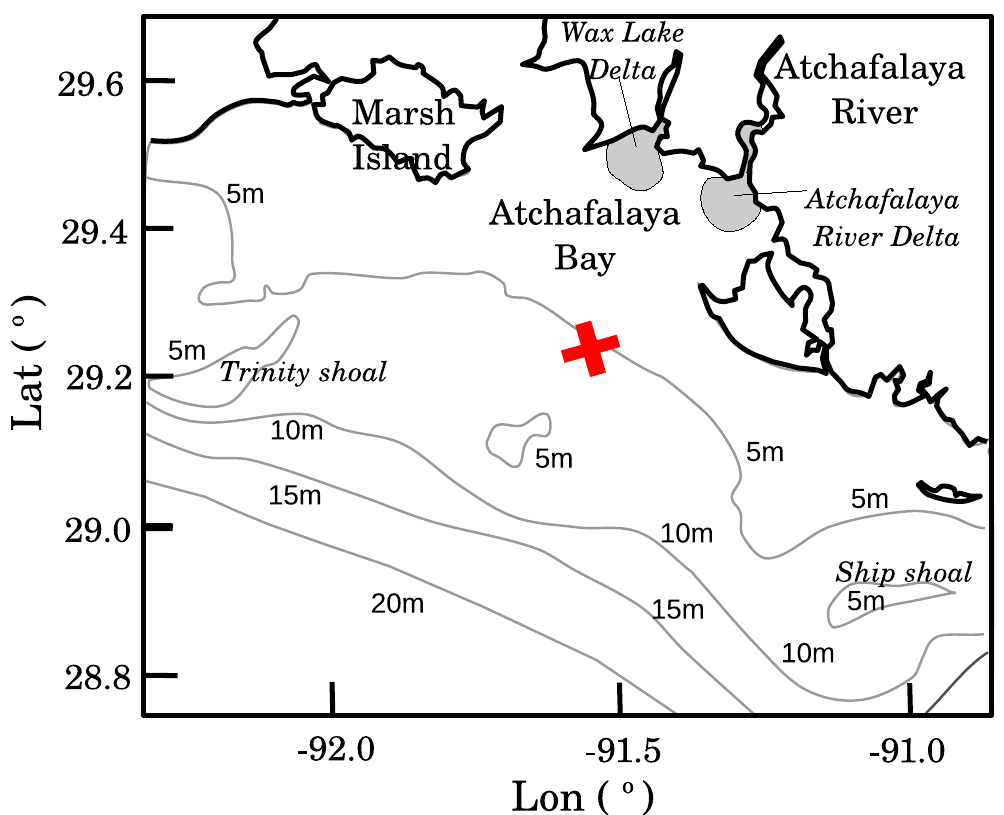
Figure 1. Map of the Atchafalaya Shelf and the bottom isobaths. The "x" indicates the location of the instrumentation platform at about 5 m water